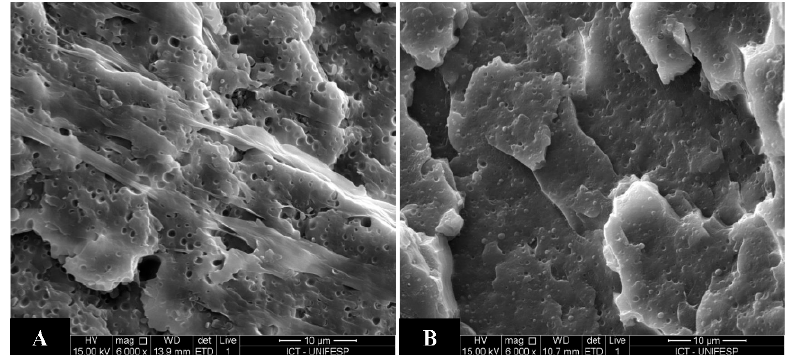
Figure 9. SEM micrographs of ( a ) PA6/LLDPE (90/10) and ( b ) PA6/LLDPE/LLDPE- g -MA (90/5/5).